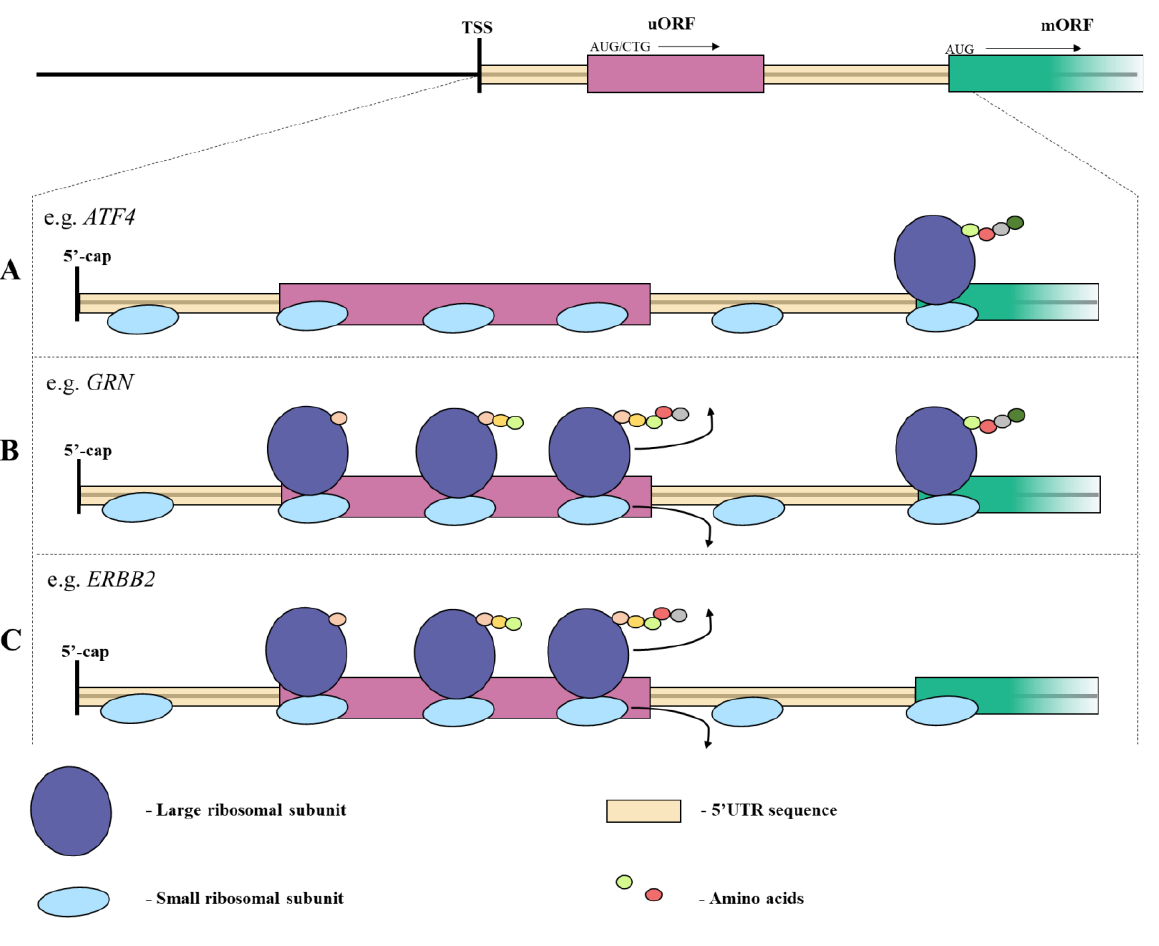
Figure 1. The most common uORF-mediated translation regulation pathways. ( A ) The leaky scanning phenomenon—uORF ribosome bypass without uProtein formation; ( B ) Production of uProteins by ribosomes, partial disassociation of the translational factors, and re-initiation of the mORF translation; ( C ) Production of uProteins by ribosomes, disassociation of the translational factors, and no translation of mORF.